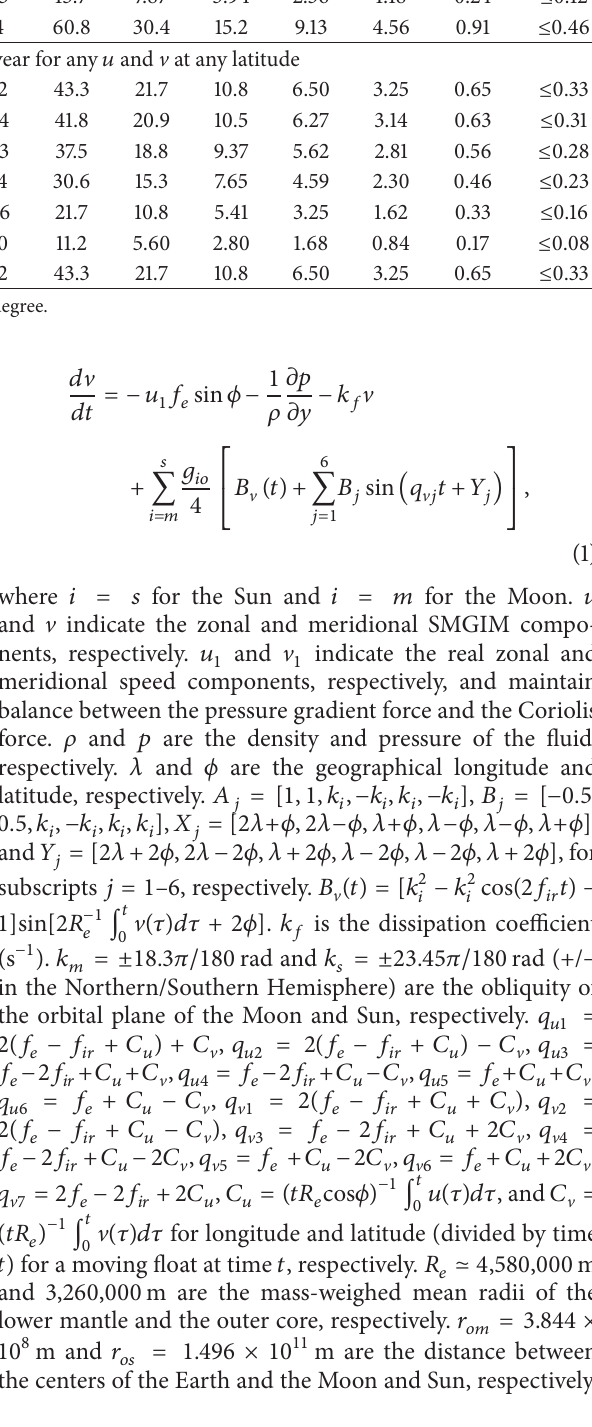
Half a year for any 𝑢 and V at any